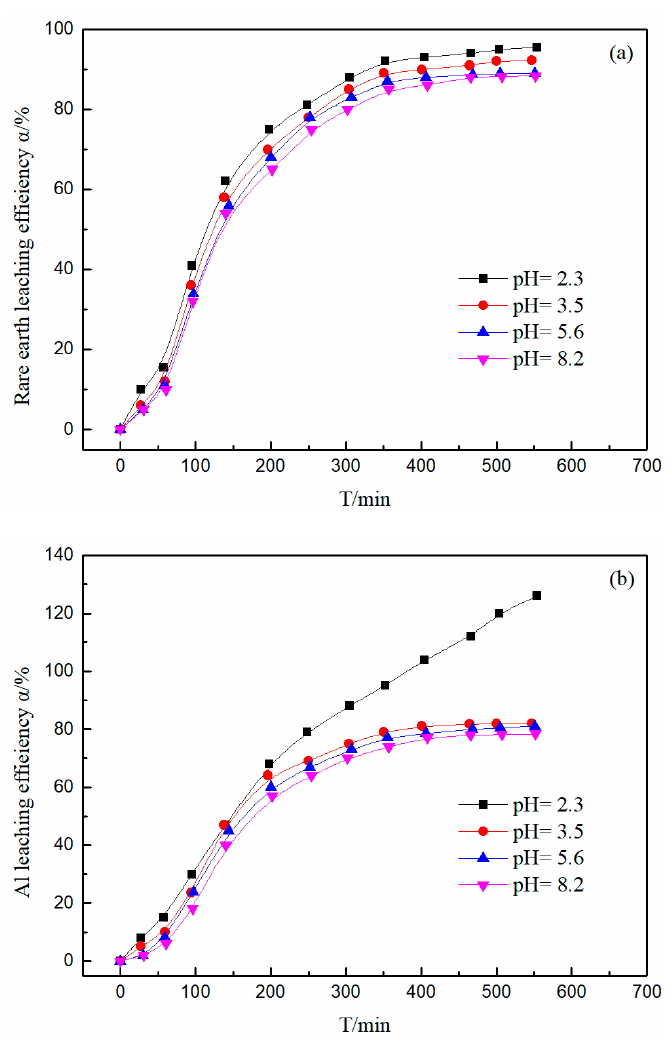
Figure 8. The effect of pH on the leaching efficiency of ( a ) RE and ( b ) Al (250 g ore; C Mg2+ = 0.2 mol/L; flow rate = 0.5 mL/L; liquid: solid = 1.2:1; room temperature).